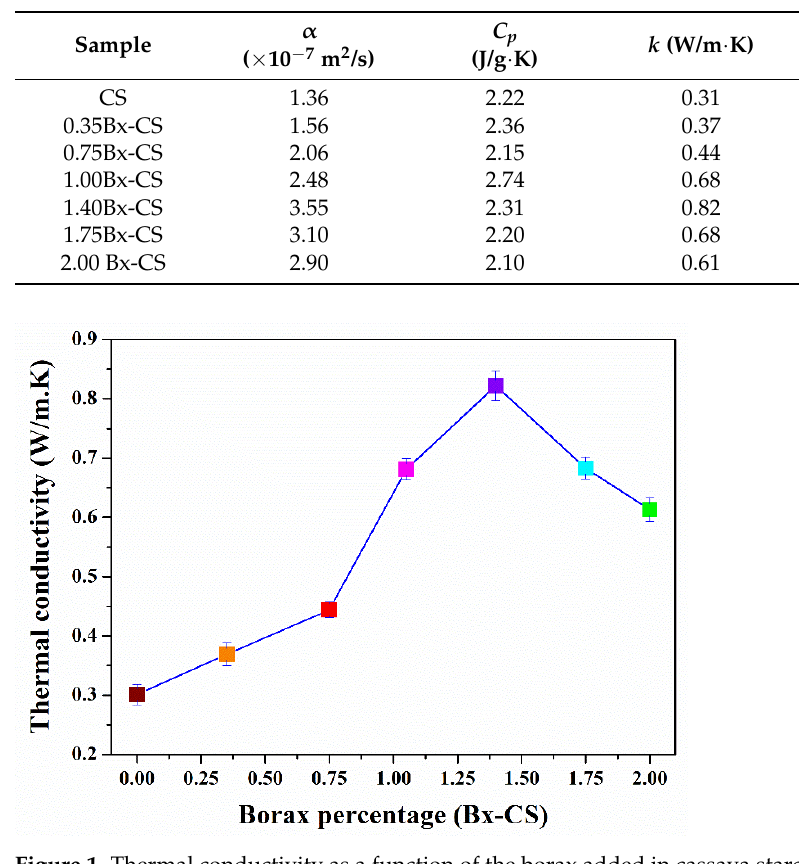
Figure 1. Thermal conductivity as a function of the borax added in cassava starch biopolymer films.